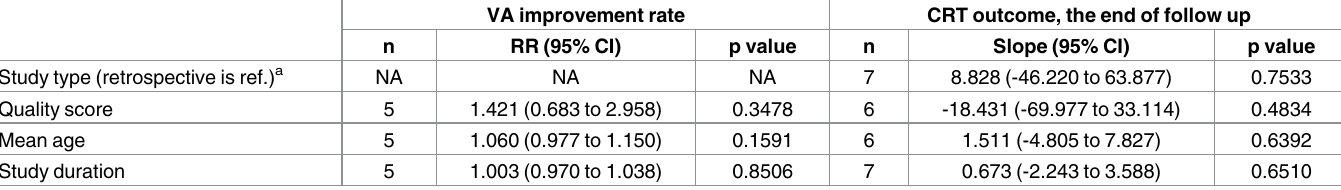
Table 5. Meta-regression analysis of heterogeneity and moderator effects of study characteristics on high heterogeneity